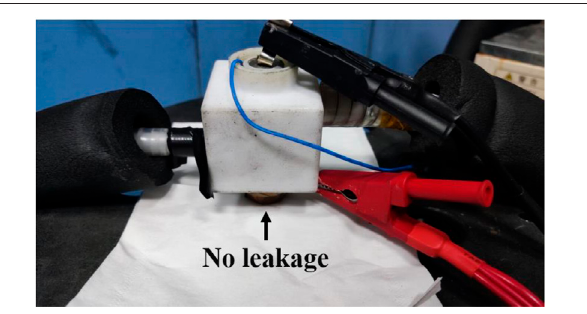
FIGURE 4 | Schematic diagram of water immersion cooling system and leakage